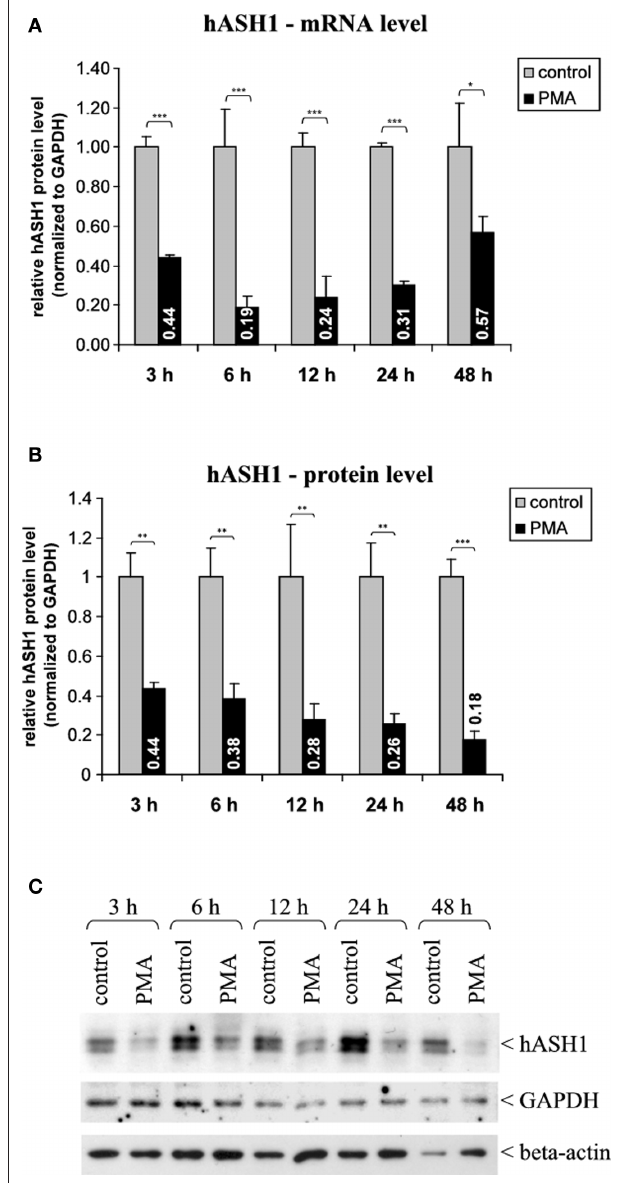
Figure 2 | reporter gene assays. Kelly cells were transiently transfected (36 h) with reporter gene vectors containing either the ASCL1 promoter sequence or the hASH1 mRNA 5 ′ - and 3 ′ UTRs followed by PMA administration (40 nM). In hASH1 mRNA UTR-dependent reporter assays the firefly-luciferase transcription rate was controlled by the constitutive SV40 promoter. Values of firefly-luciferase activity were normalized to the co-transfected renilla-luciferase. (A) Influence of ASCL1 promoter on PMA-mediated reporter gene activity. (B) hASH1 mRNA 5 ′ - and 3 ′ UTR- dependent response on gene expression rate following PMA treatment. n = 12; * p < 0.05, ** p < 0.01, *** p <